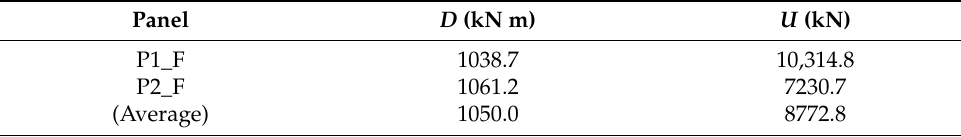
Table 7. Flexural and shear stiffness values obtained experimentally.